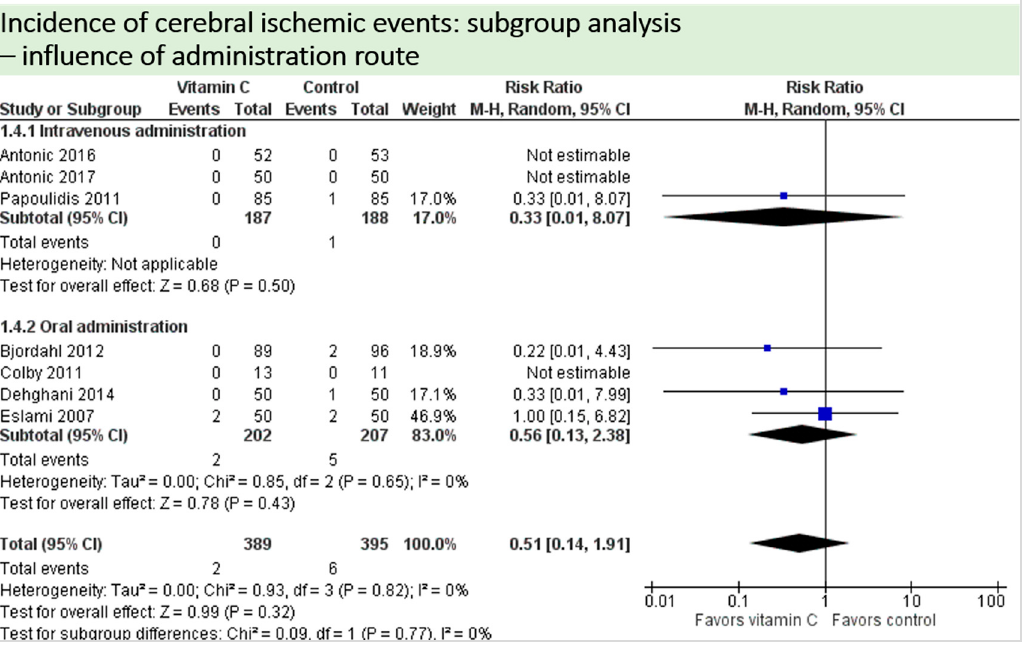
Figure 10. Cerebral ischemic events: subgroup analysis—influence of administration route.